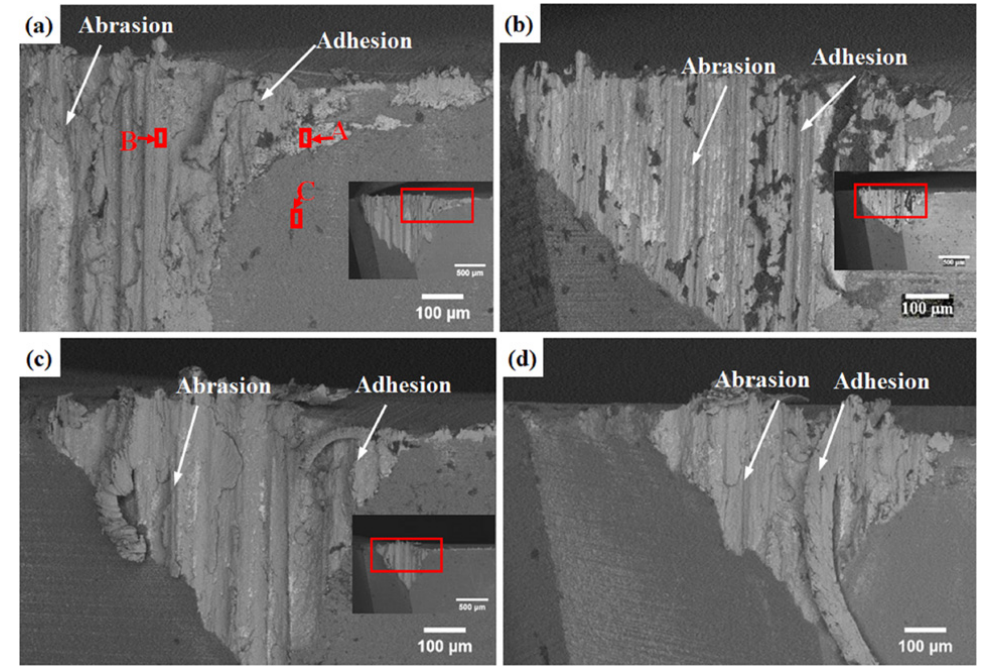
Figure 6. The worn flank face of ( a ) TiAlN/WT1, ( b ) TiAlN/WT2, ( c ) TiAlN/WT3 and ( d ) TiAlN/WT4 coated cemented carbides after stainless steel turning.